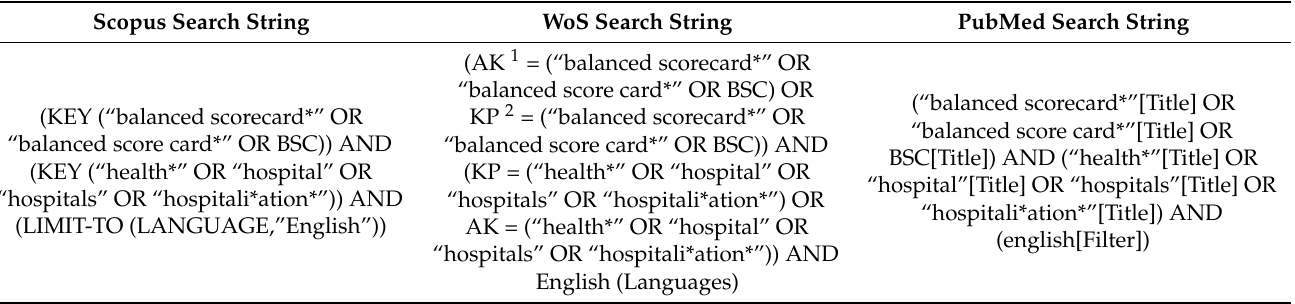
Table 1. Search strings ( 1 author keywords (AK); 2 keywords plus (KP)). Scopus Search String WoS Search String PubMed Search